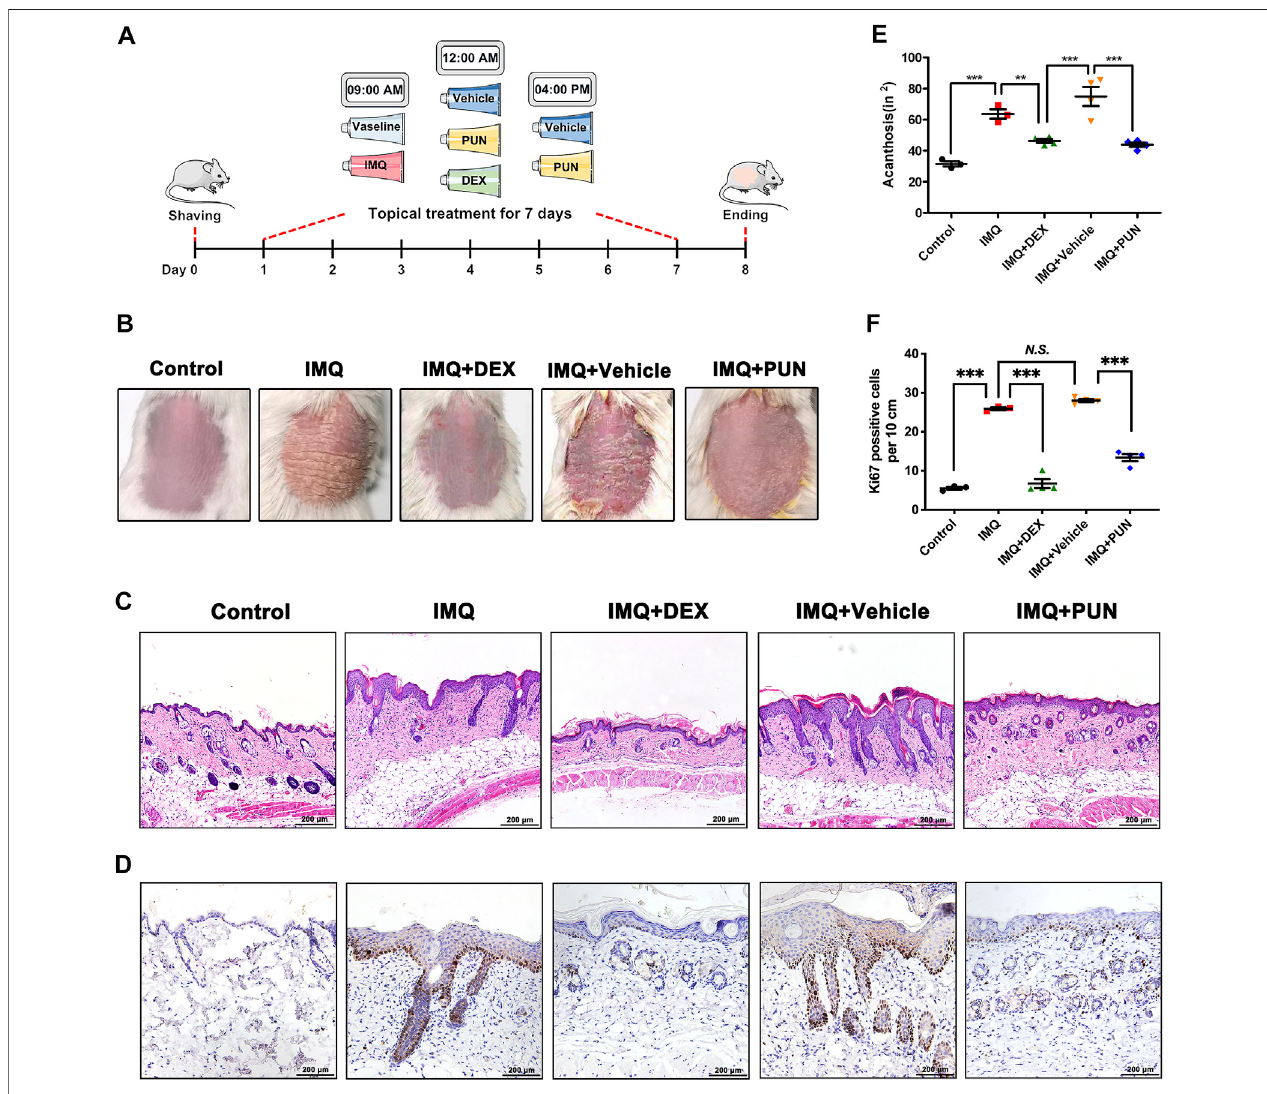
FIGURE 1 | Punicalagin signi fi cantly ameliorates IMQ-induced psoriasis-like symptoms in vivo . (A) A schematic showing the experimental design. (B) Phenotypic appearancesofmicebackskininControl/IMQ/IMQ+DEX/IMQ+Vehicle/IMQ+PUNgroupsonday8. (C) HistologicalchangesofmicebackskininControl/IMQ/IMQ+ DEX/IMQ +Vehicle/IMQ +PUNgroups. Scalebar,200 μ m. (D) Ki67stainingofmice backskininControl/IMQ/IMQ +DEX/IMQ +Vehicle/IMQ +PUNgroups. Scalebar, 200 μ m. (E) Histological analysis of acanthosis in Control/IMQ/IMQ + DEX/IMQ + Vehicle/IMQ + PUN groups. (F) The numbers of Ki67 positive cells in lesion skin derived from mice treated with Vaseline/IMQ/IMQ + DEX/IMQ + Vehicle/IMQ + PUN. ** p < 0.01, *** p < 0.001, N.S. , non-signi fi cant. One-way ANOVA with Student- Newman-Keuls method for (E, F) . Data represent the mean ± S.E.M.